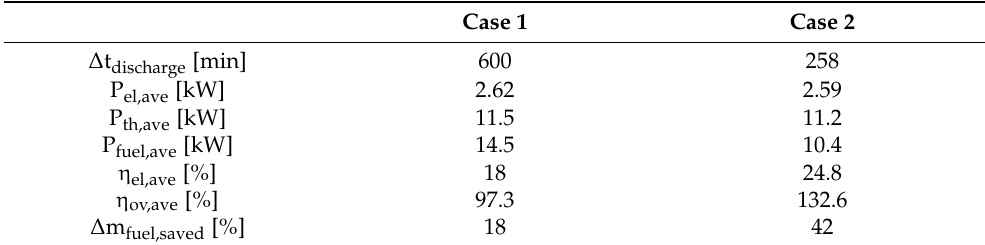
Table 4. Averaged performance parameters of the compound for one HTES discharge cycle.